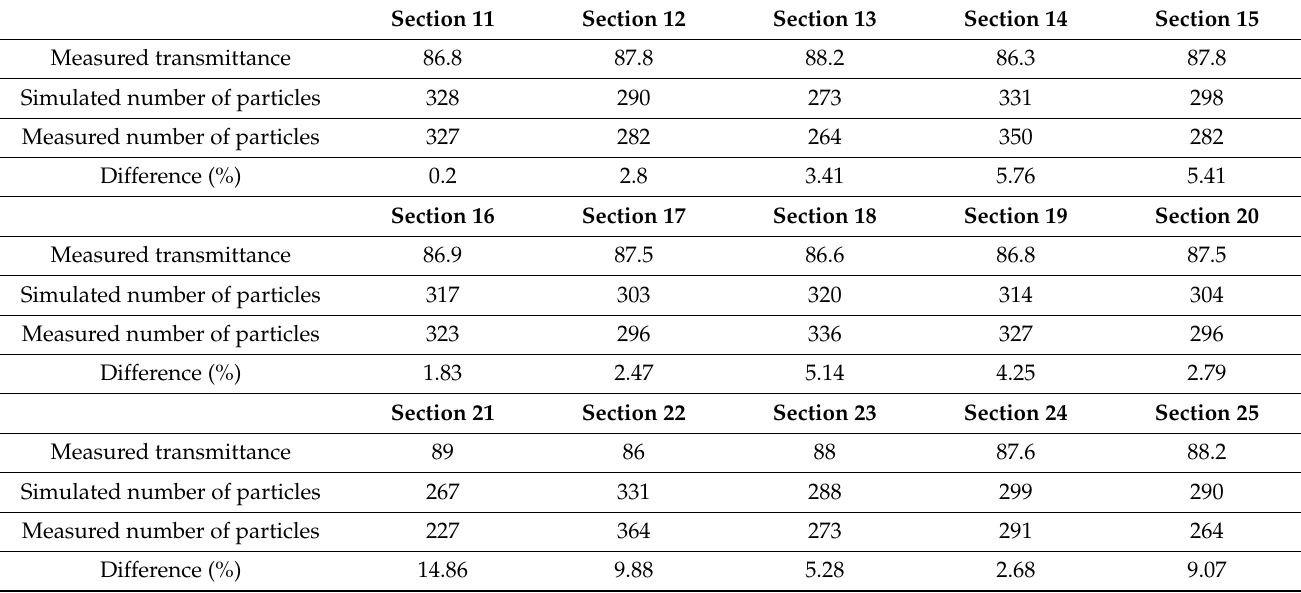
Figure 11. Manual measurement result of light transmittance after 3.5 days of dust deposition.